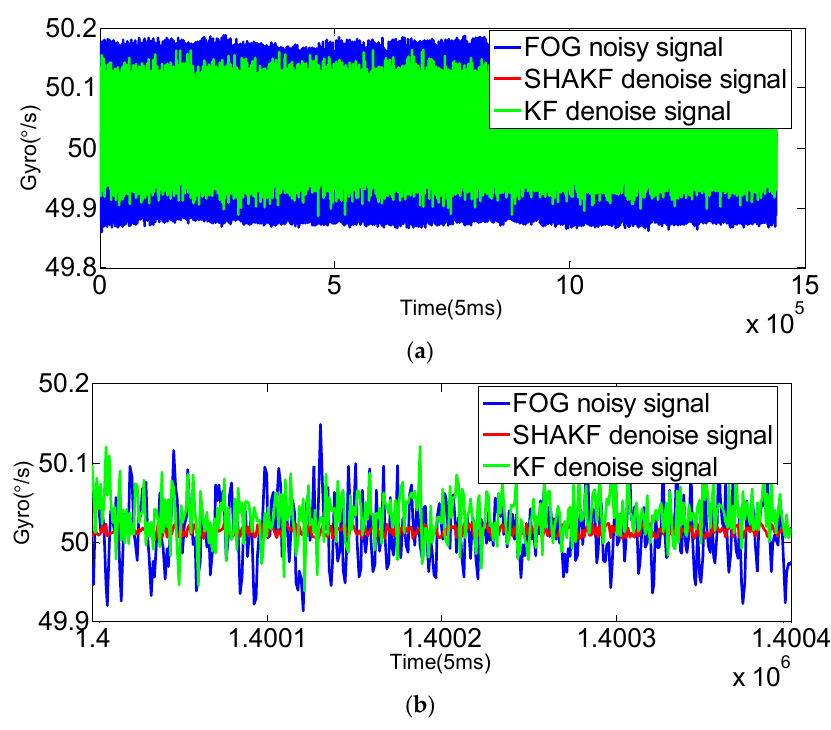
Figure 14. Comparison of the results before and after denoising for the FOG dynamic signal at a rate of 50°/s. ( a ) Denoising results of the FOG dynamic signal ( x -axis) for 2 h; ( b ) local enlarged graphs. Mean square error (MSE), root mean square error (RMSE) or the signal-to-noise power ratio (SNR) [9] are generally employed to compare the performance of denoising methods before and after denoising the FOG dynamic drift signal. The MSE is defined as follows: